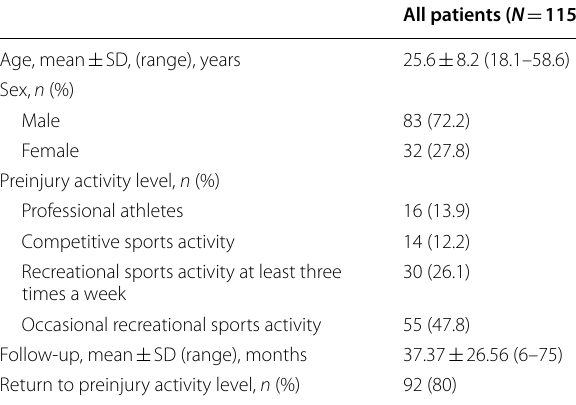
Table 1 Patient demographics